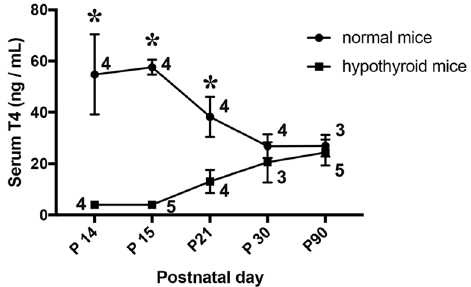
Figure 2. Change in serum T 4 after termination of treatment with antithyroid agents. Replacement of drinking water that included antithyroid agents with normal water at PD 14. Serum T 4 levels in hypothyroid mice caught up to the same level as normal mice 2 weeks later. Arabic numerals in line graphs indicate the number of animals. *p < 0.0001 vs. normal